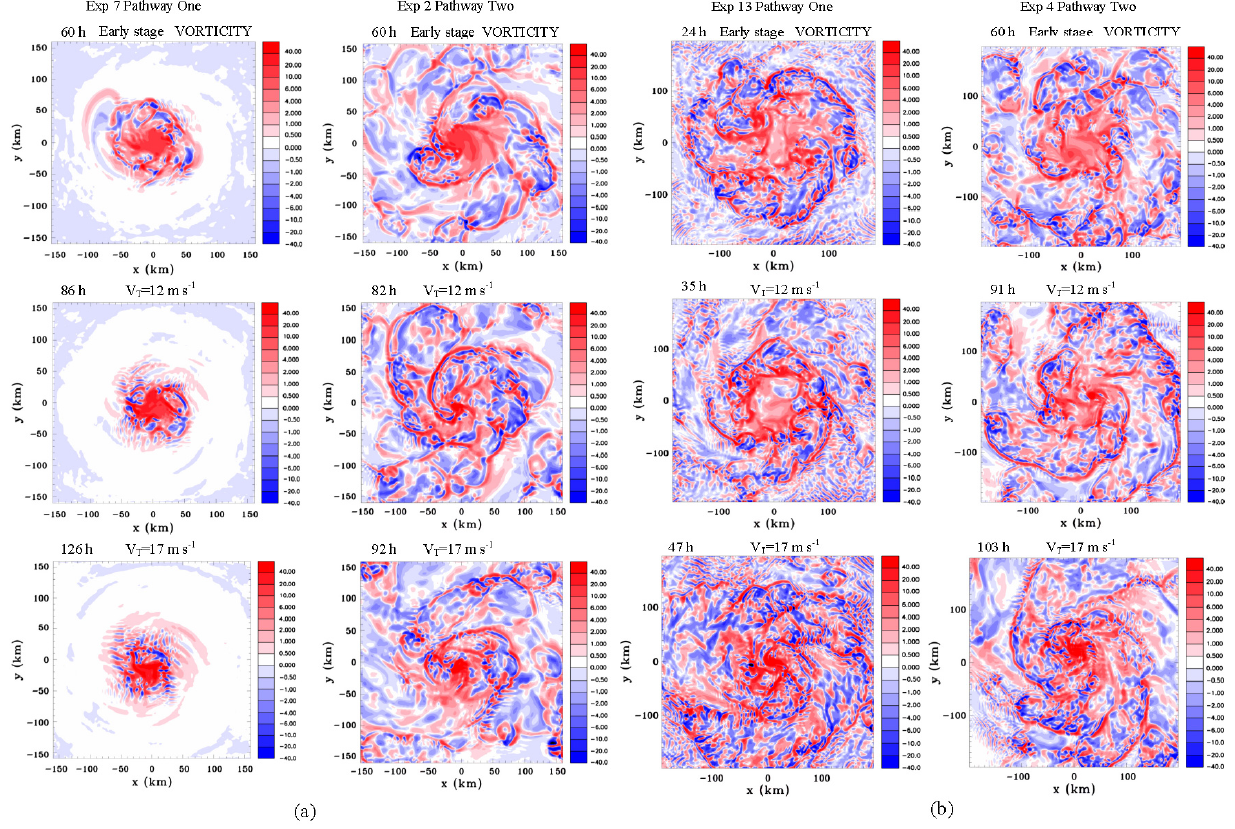
Fig. 2. Examples of development along pathway One and pathway Two, showing vertical vorticity ( × 10 − 4 rad s − 1 ), at z = 98 m. (a) Experiments 7 and 2 that were initialized with a small vortex, and (b) Experiments 13 and 4 that were initialized with a large vortex. V T is the azimuthally averaged tangential velocity near the